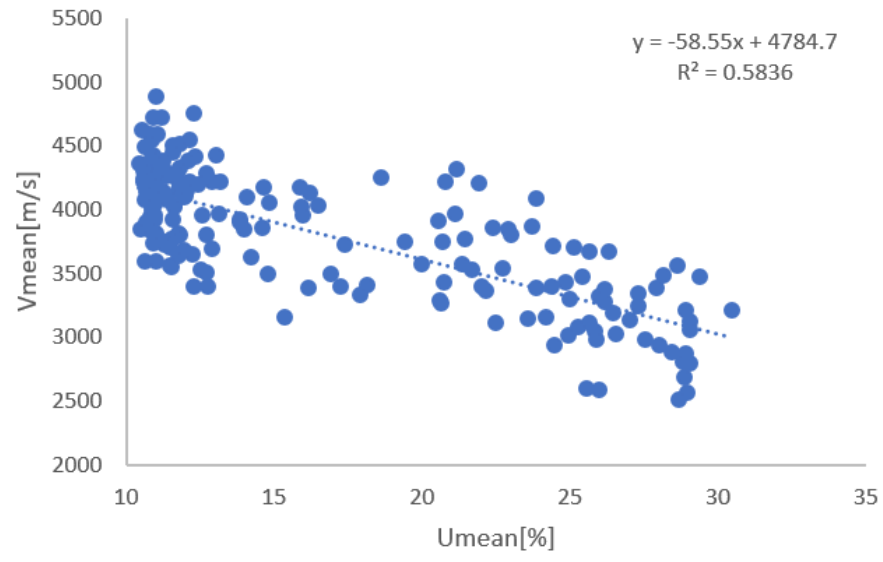
Figure 5. Velocity V as a function of moisture content U.